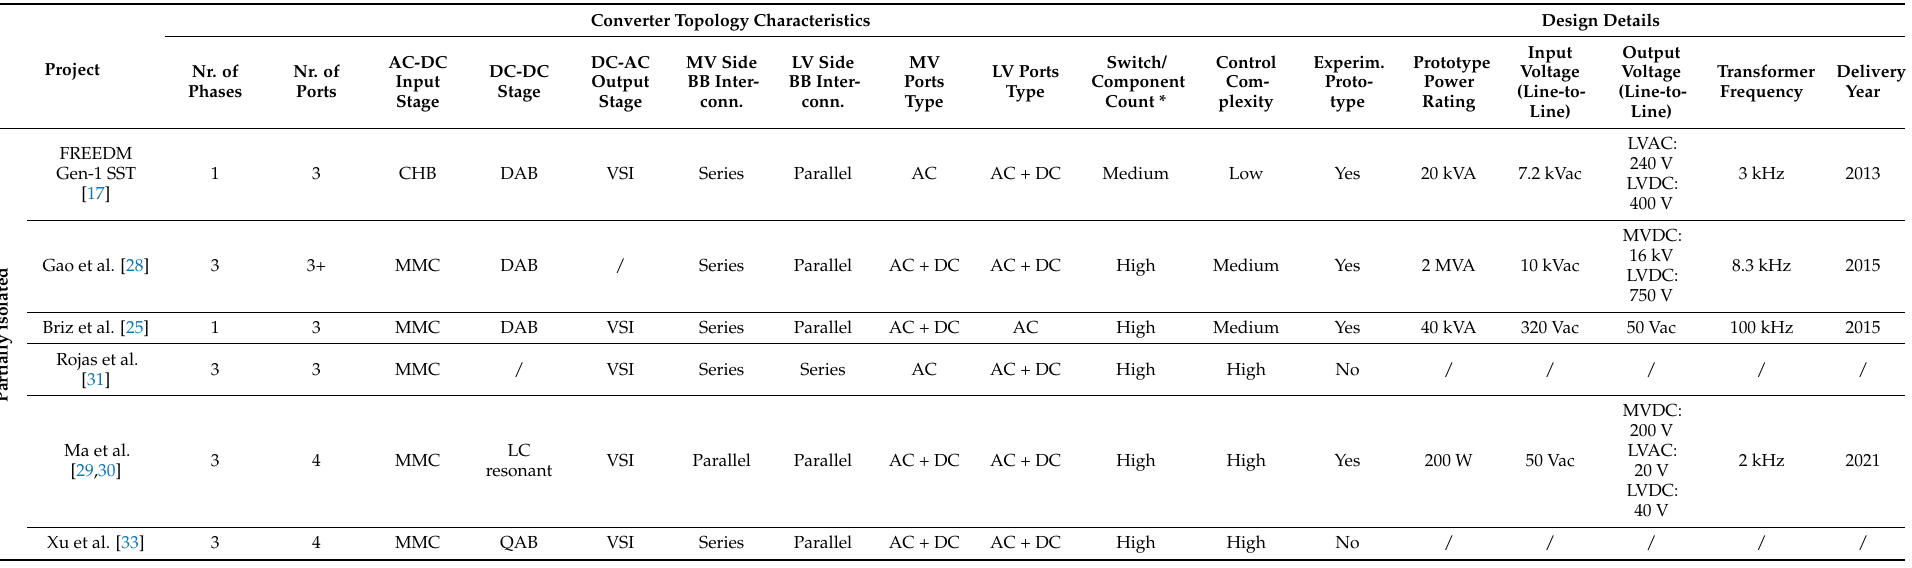
Table 1. Comparison of the most relevant SST